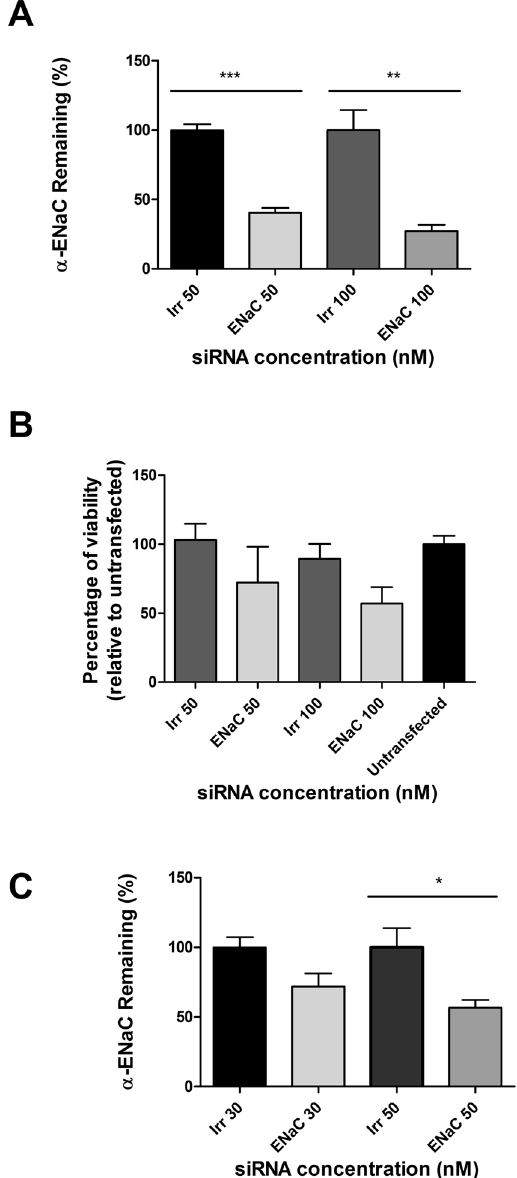
Figure 3. Primary CF epithelial cells with LPRs containing either 50 nM or 100 nM siRNA and peptide Y. ( A ) Percentage of expression of the α -ENaC mRNA after siRNA treatment in primary CF cells in submerged culture. The expression of α -ENaC was 40.5% at 50 nM and 27.2% at 100 nM, respectively. The difference was statistically significant ( *** P ≤ 0.001) at 50 nM, whereas the significance ( ** P ≤ 0.01), was lower at 100 nM. The results show the means ± S.E.M. of triplicate experiments. ( B ) Viability (percentage) of primary CF cells following transfections with LPRs formulated with peptide Y compared to untransfected cells. The α -ENaC- siRNA treated cells showed a viability of 72% at 50 nM siRNA concentration and 57% at 100 nM. Cell survival was assessed using an LDH assay measuring the light emitted at 610 nm. Results represent mean values of triplicate repeats ± S.E.M. ( C ) Percentage of remaining expression of the α -ENaC gene transcript in primary CFBE cells grown on ALI in transwell plates. The expression of the transcript of the α -ENaC gene was 71.8% at 30 nM and 56.7% at 50 nM. The difference was statistically significant only at 50 nM ( * P ≤ 0.05). qRT-PCR analysis was performed in triplicate on individual samples. The mRNA levels of the α -ENaC gene are expressed as percentage of irrelevant/non-targeted control